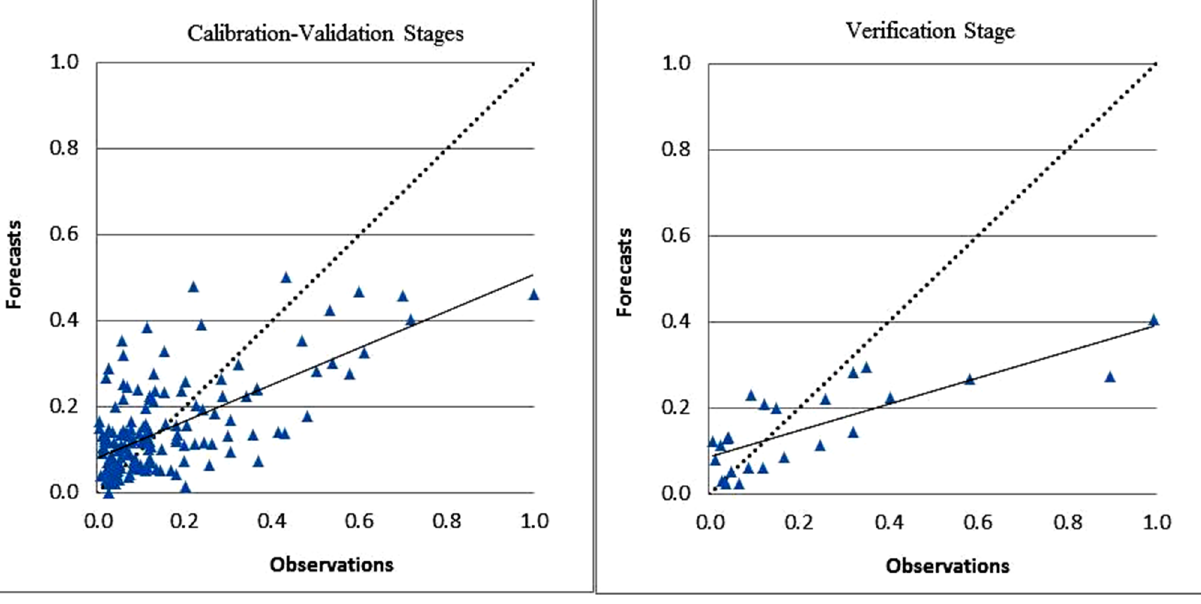
Figure 5. Final results of standardized forecasts vs. standardized observations using the NLMR